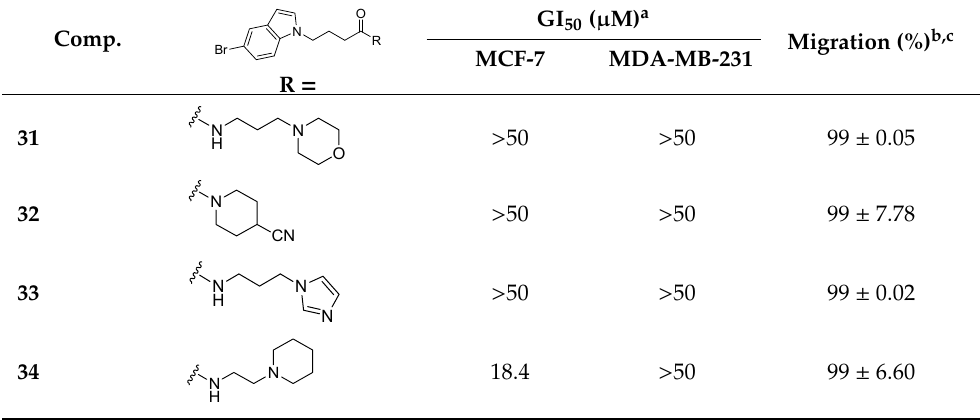
Table 2 . Cell growth inhibition and anti-migration activity of 5-bromoindole derivatives. Comp.